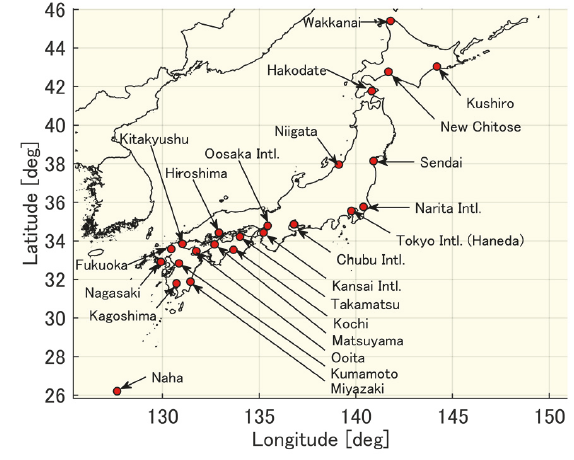
Figure 13: Main airports in Japan.